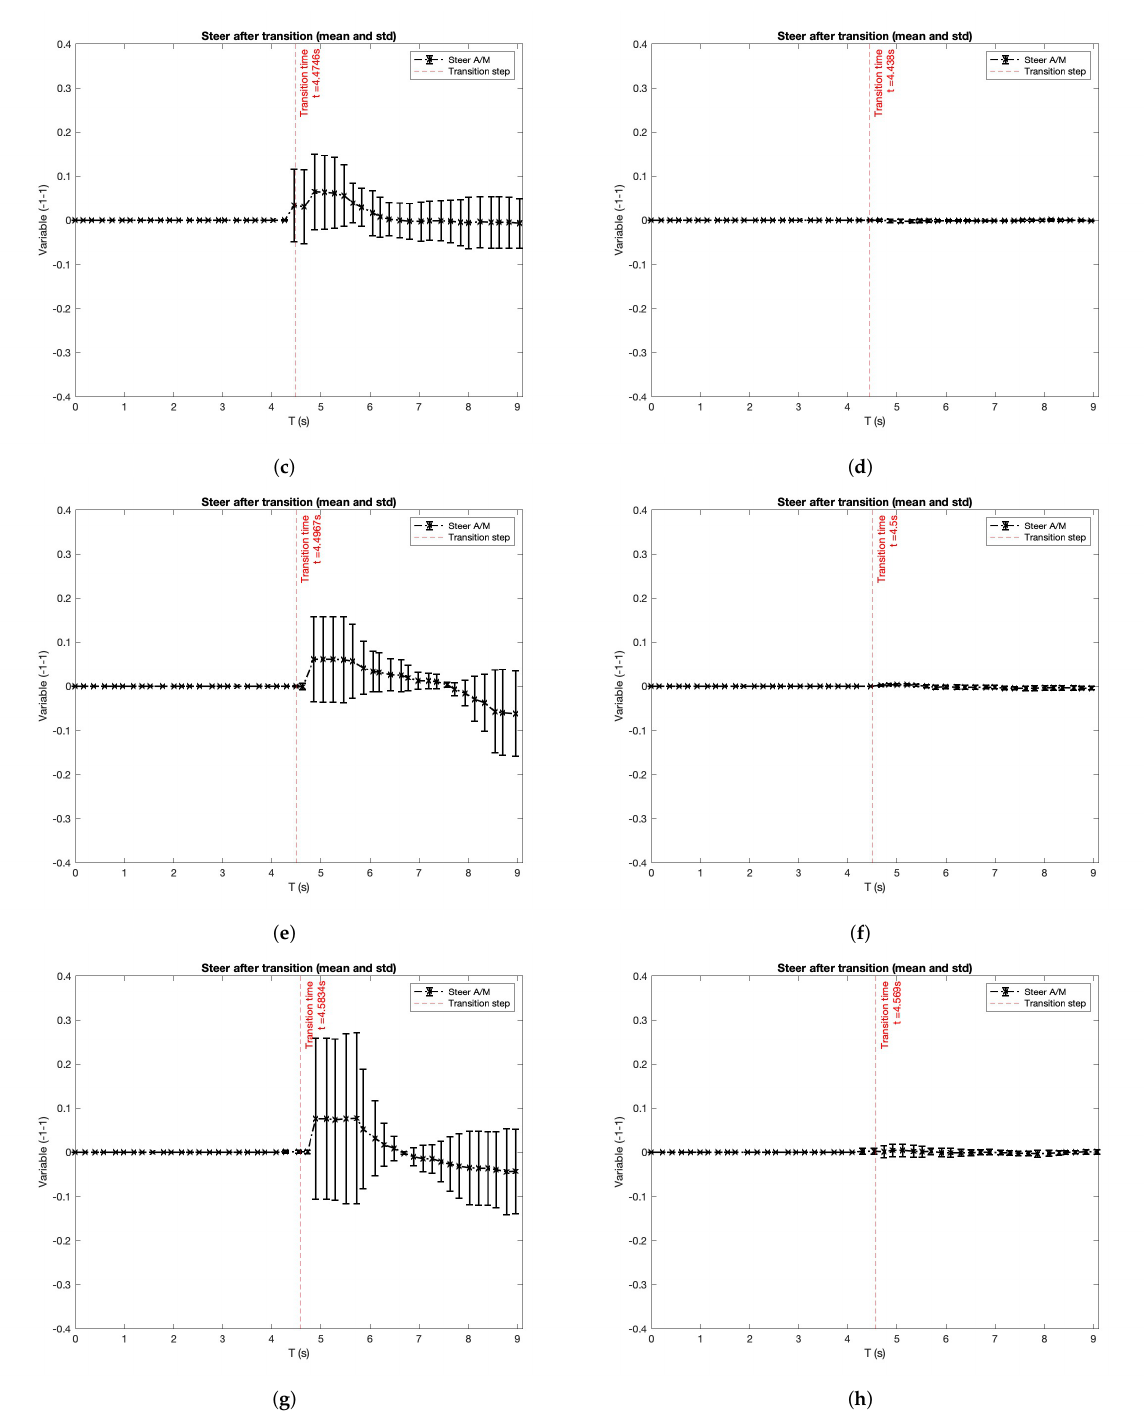
Figure 12. Steer analysis after transition (mean and standard deviation). Transitions are splitted in Autonomous to Manual (A/M). ( a ) Experiment: ACC. Driver attention: focus. ( b ) Experiment: ACC + passing. Driver attention: focus. ( c ) Experiment: ACC. Driver attention: using the mobile phone. ( d ) Experiment: ACC + passing. Driver attention: using the mobile phone. ( e ) Experiment: ACC. Driver attention: reading. ( f ) Experiment: ACC + passing. Driver attention: reading. ( g ) Experi- ment: ACC. Driver attention: talking to passenger. ( h ) Experiment: ACC + passing. Driver attention: talking to